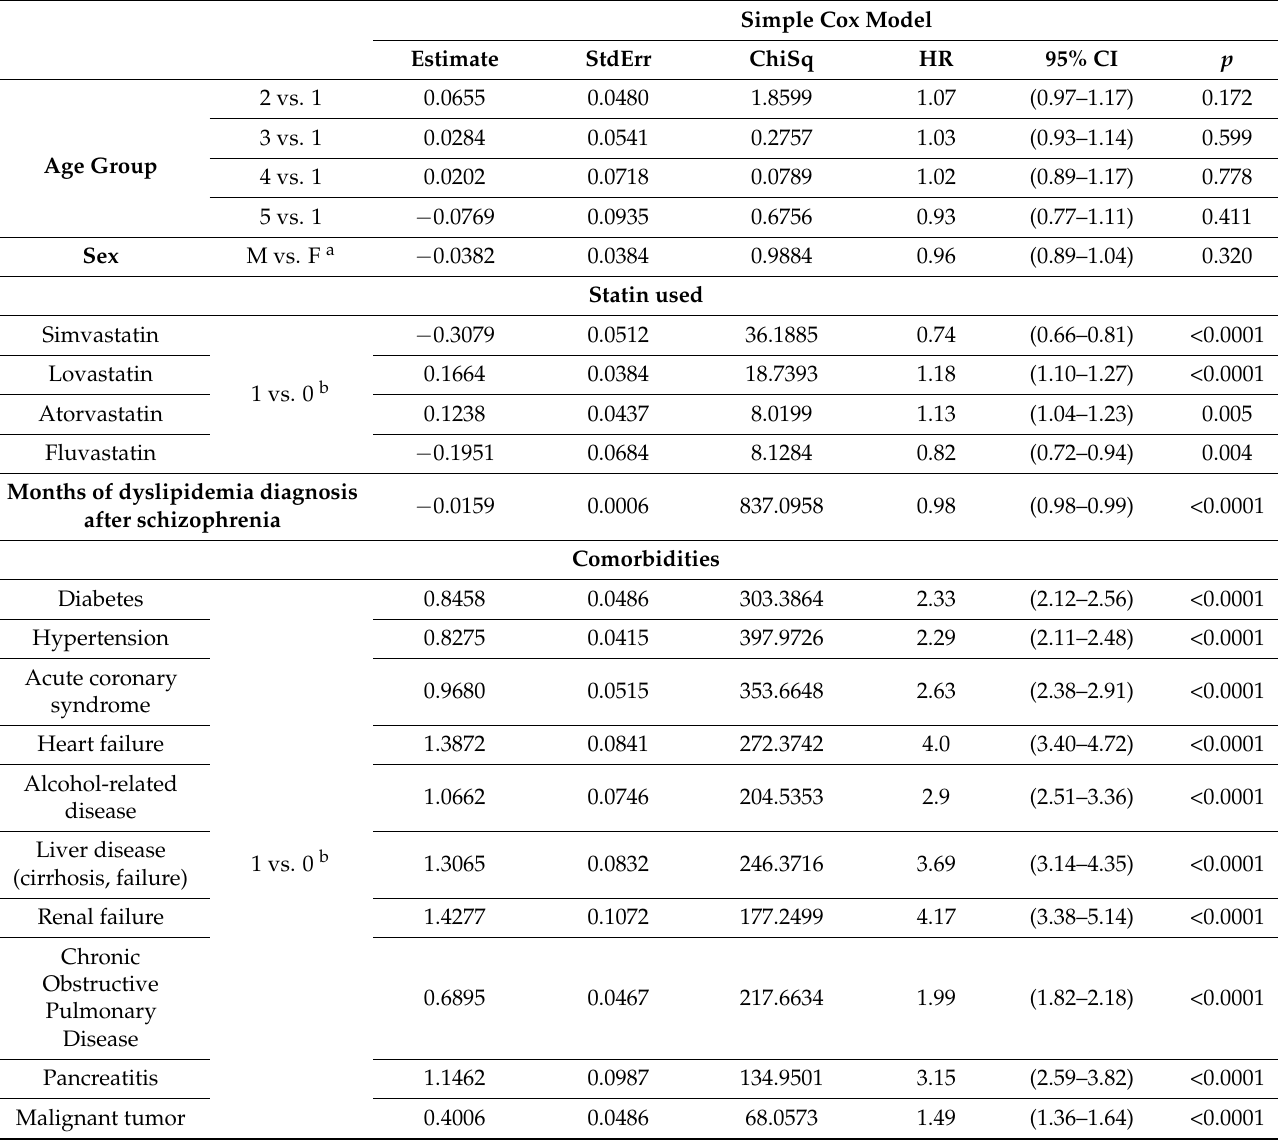
Table 2. Simple cox proportional hazard regression models for overall